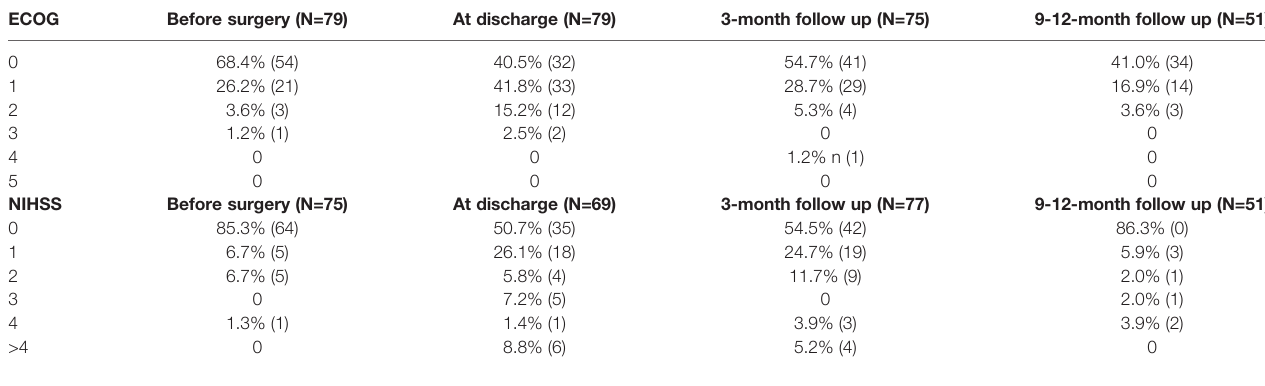
TABLE 3 | The Eastern Cooperative Oncology Group (ECOG) and National Institute for Stroke Scale (NIHSS) before surgery, at discharge and during follow up. ECOG Before surgery (N=79) At discharge (N=79)